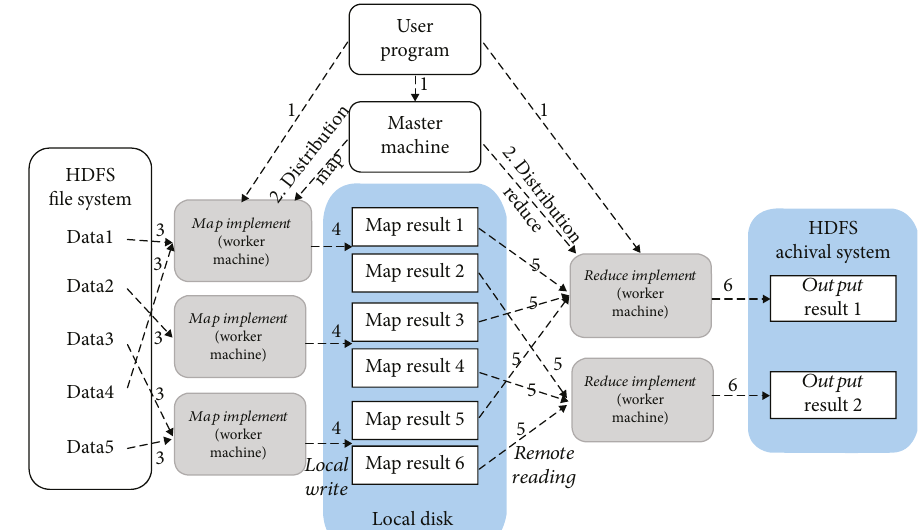
Figure 6: MapReduce operating mechanism diagram.